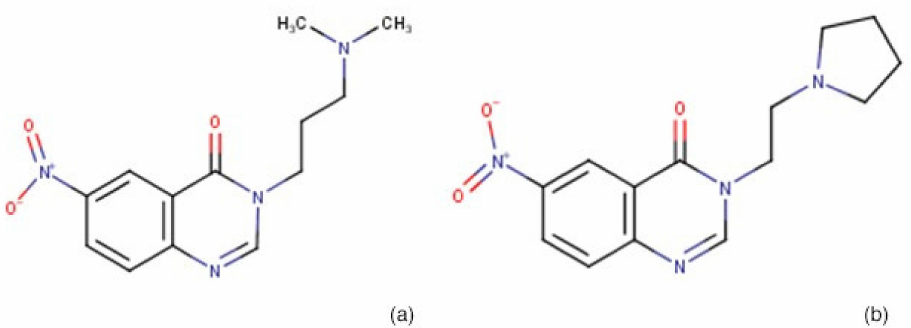
Figure 9. Chemical structures of quinazoline derivatives: ( a ) BG1189 and ( b )